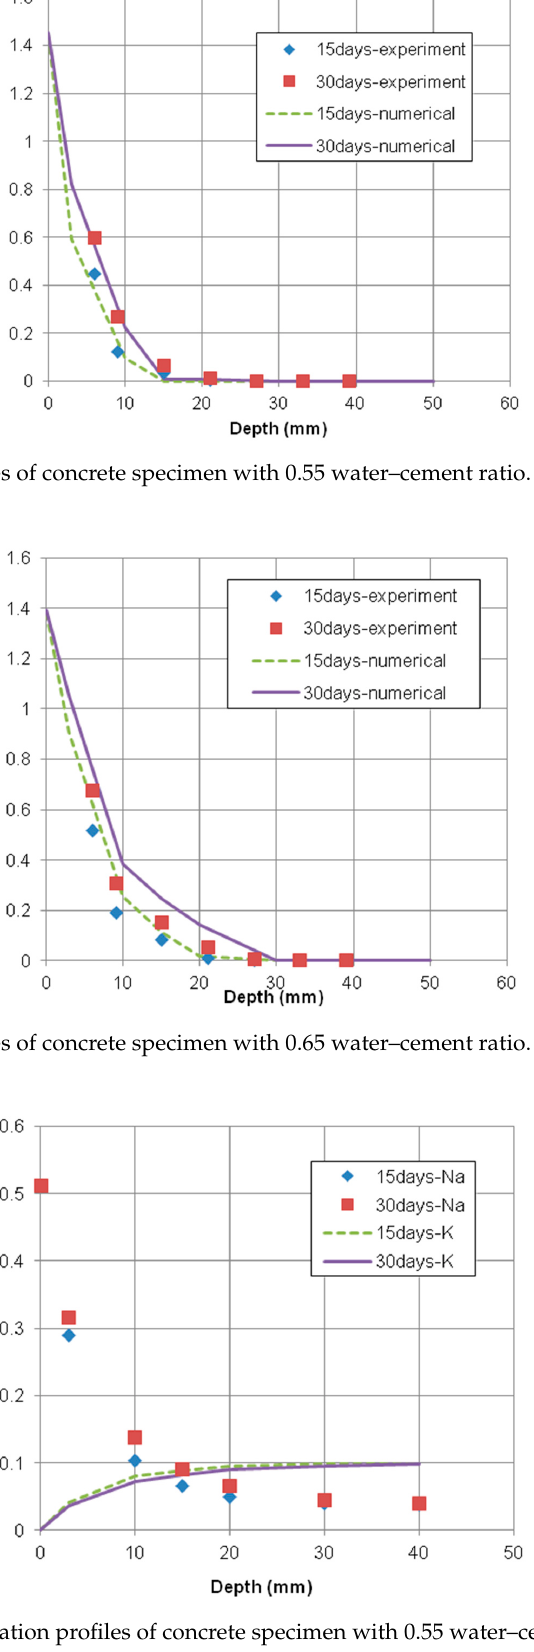
Figure 5. Cation concentration profiles of concrete specimen with 0.55 water–cement ratio. Exposed for 15 days and 30 days.